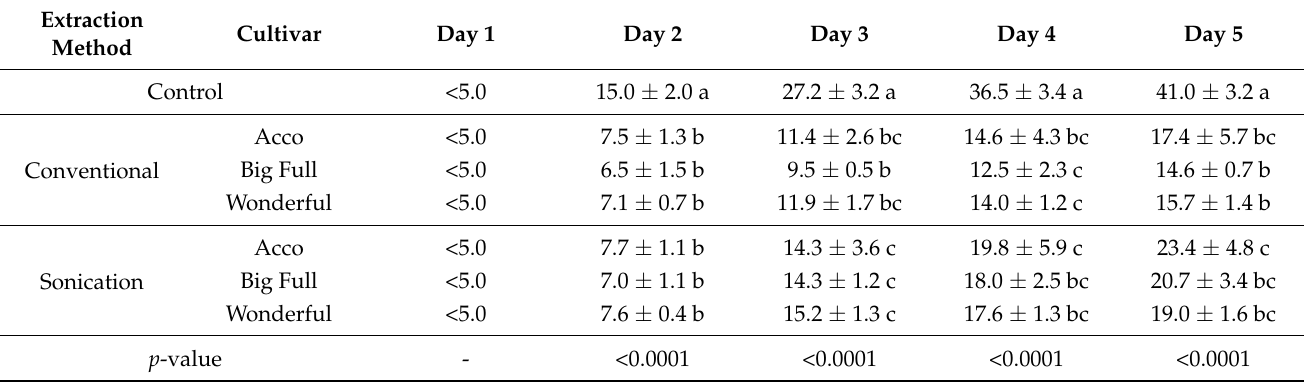
Table 9. Root length (mm) of garden-cress seeds, in the presence of water (control) and pomegranate peel extracts (0.003